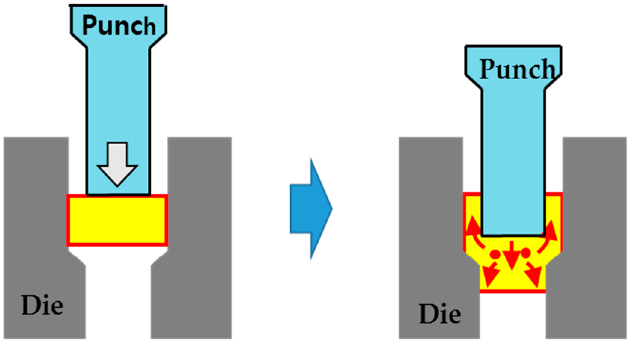
Figure 1. A schematic drawing of combined forward–backward extrusion.